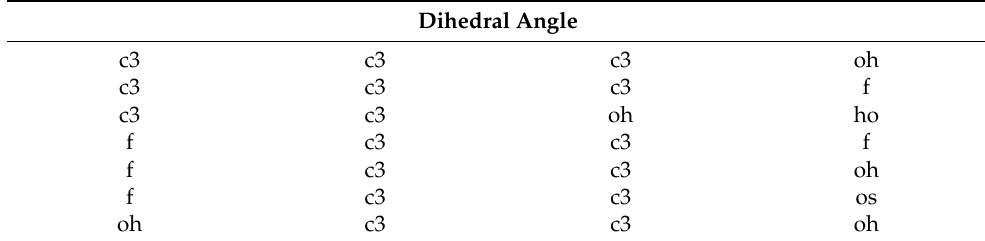
Table 1. List of dihedral angles fitted with atom types assigned by tLeap